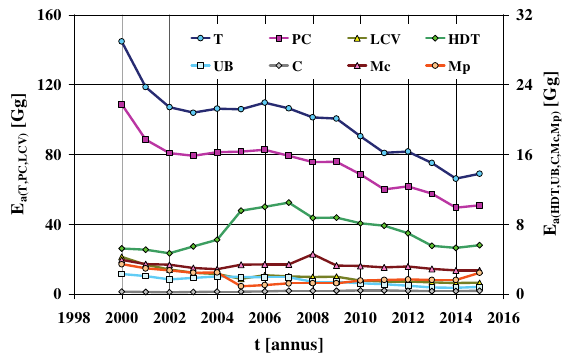
Fig. 7. Average vehicle velocity per cumulated vehicle category, under Fig. 10. National annual emission of volatile organic compounds per model traffic conditions: rural cumulated vehicle category The average mileage of vehicle after engine start was National annual emission is differentiated for different assumed to be 12 km [1]. pollutants and cumulative vehicle categories. Generally for carbon monoxide and volatile organic compounds, there is a marked tendency of declining national annual